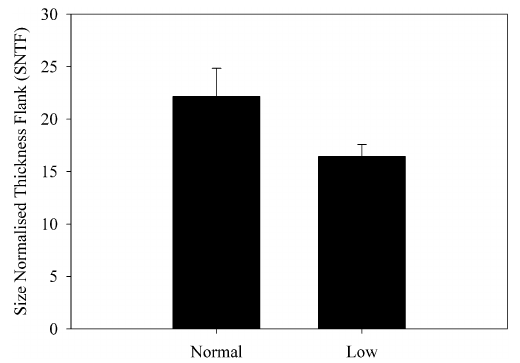
Figure 5. Size-normalised thickness of the flank (SNTF). Nor- mal=pH n -shells, low=pH low -shells.